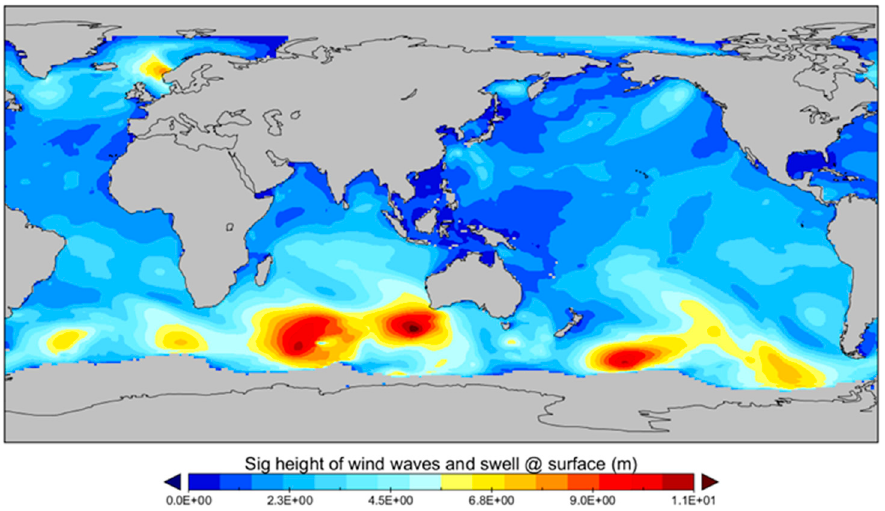
Figure 7. Effective wave height from WAVEWATCH Ⅲ (14:00 15 July 2007 Beijing time).